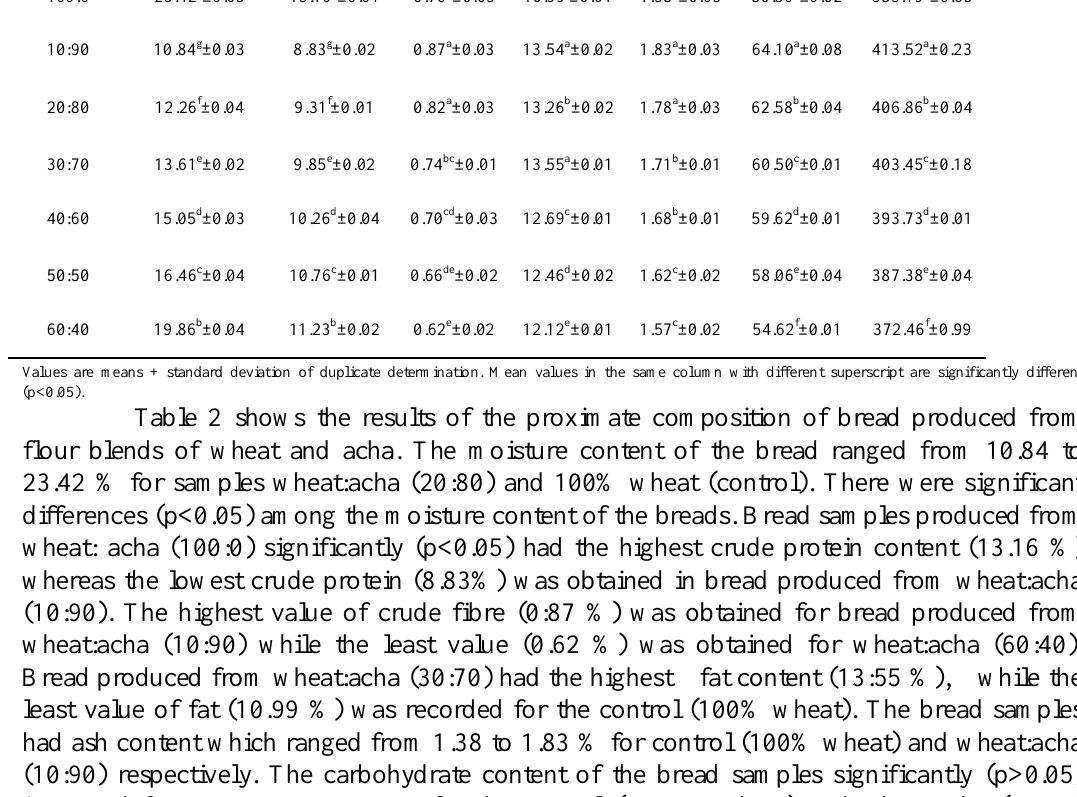
Table 2: Proximate Composition of Bread produced from Flour Blends of Wheat and Acha